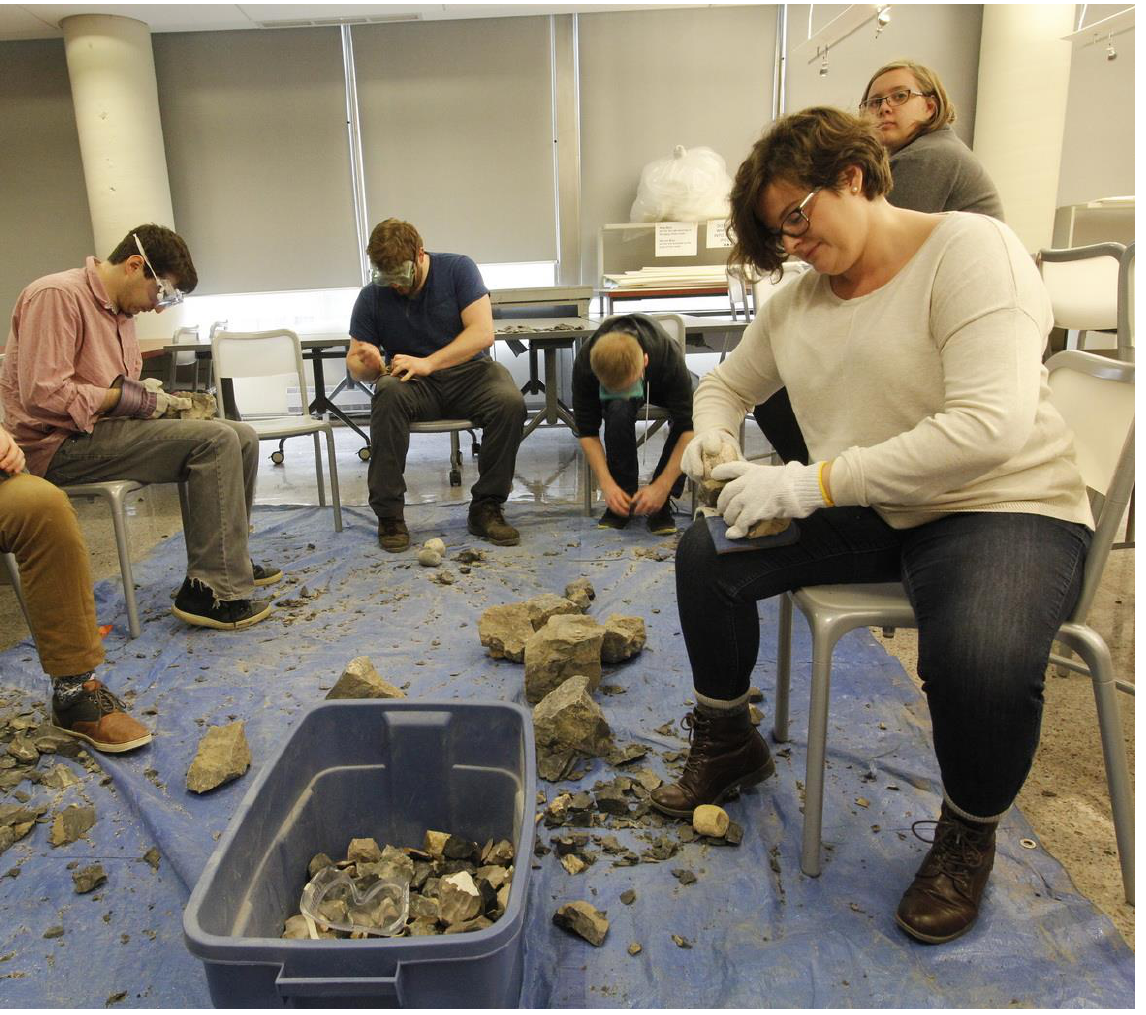
Figure 2. Knappers practice their skills on local Onondaga